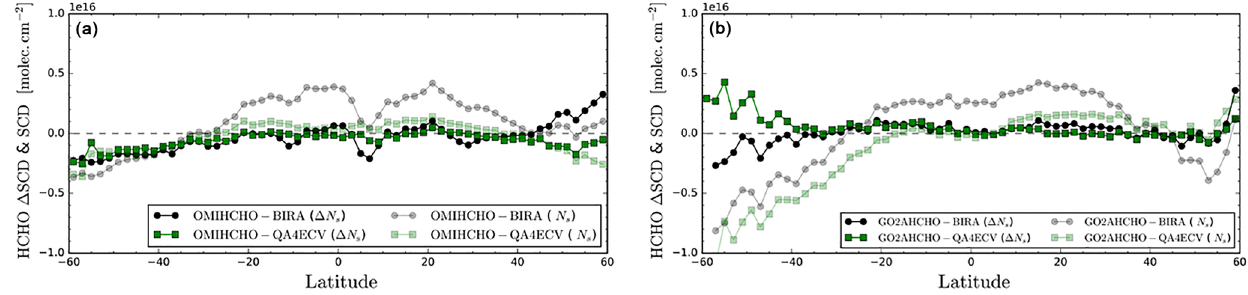
Figure 2. Average differential HCHO slant columns within 2 ◦ wide latitudinal bins for (a) OMIHCHO–BIRA (black circles) and OMIHCHO–QA4ECV (green squares) for the Pacific (60 ◦ N–60 ◦ S and 150–180 ◦ W) orbit from day 1 of January, April, July, and Oc- tober (or closest available data) 2005–2015, and for (b) GO2AHCHO–BIRA (black circles) and GO2AHCHO–QA4ECV (green squares) for the Pacific orbits from day 1 of January up to December and from day 15 of January, April, July, and October (or closest available data) 2007–June 2014 and 2007–2015 respectively. The light grey and green lines represent the HCHO SCDs before the background